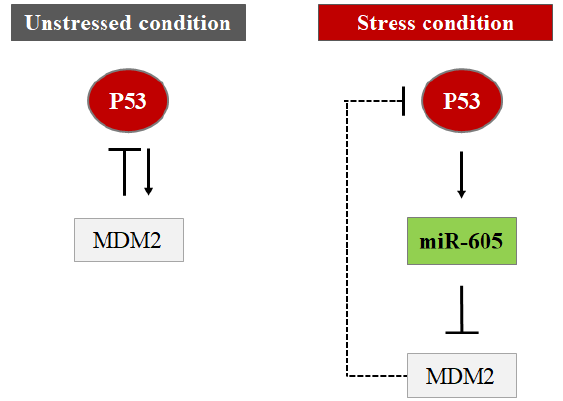
Figure 8. The regulation of MDM2 by miR-605. In normal conditions, P53 activates the transcription of MDM2, which in turn targets P53 for repression, creating a negative feedback loop to inhibit P53 level and function. In response to cellular stress, P53 enhances the miR-605 expression and miR-605 upregulation increases the activity of P53 by repressing MDM2 to remove the inhibitory effects of MDM2 on P53.